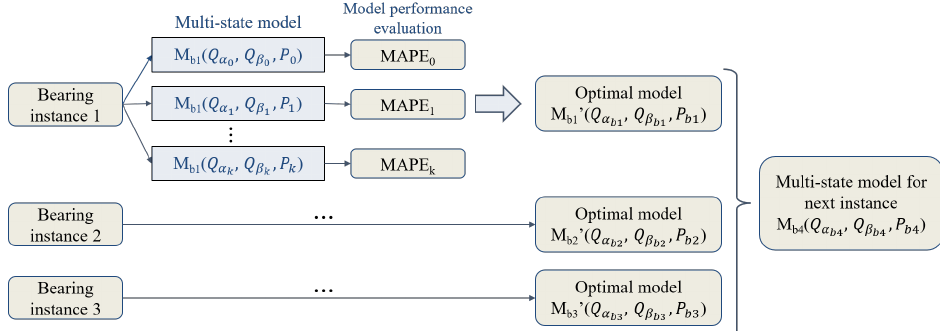
Figure 5. Framework of the training process. (given three observed bearing failure